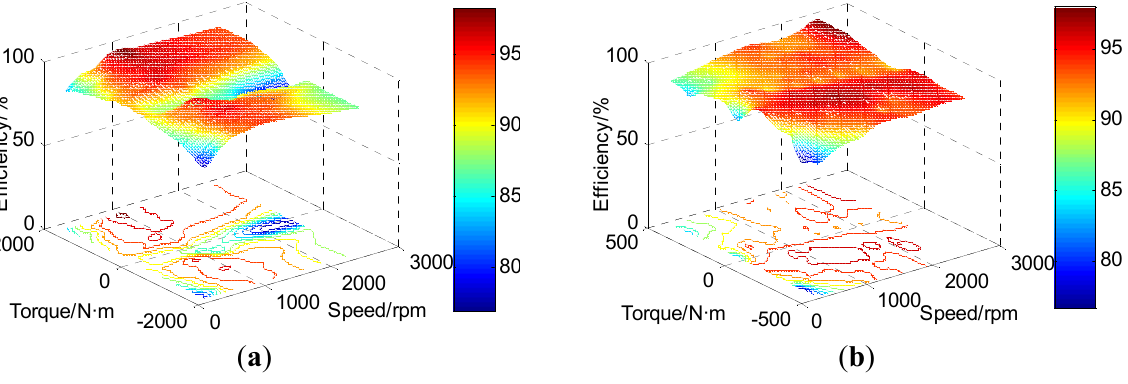
Figure 3. The efficiency MAP curves of drive motor and ISG motor: ( a ) Drive motor efficiency ( b ) ISG motor